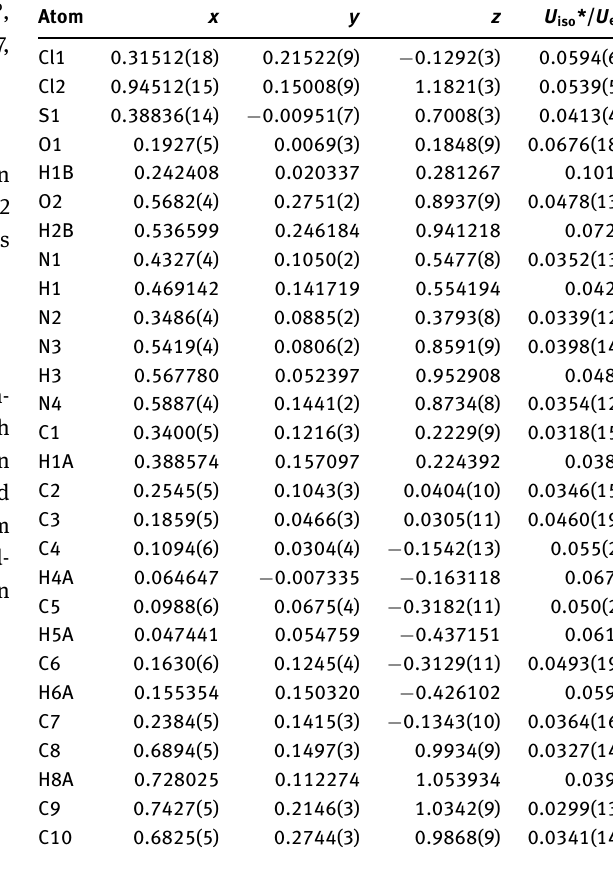
Table 2: Fractional atomic coordinates and isotropic or equivalent isotropic displacement parameters (Å 2